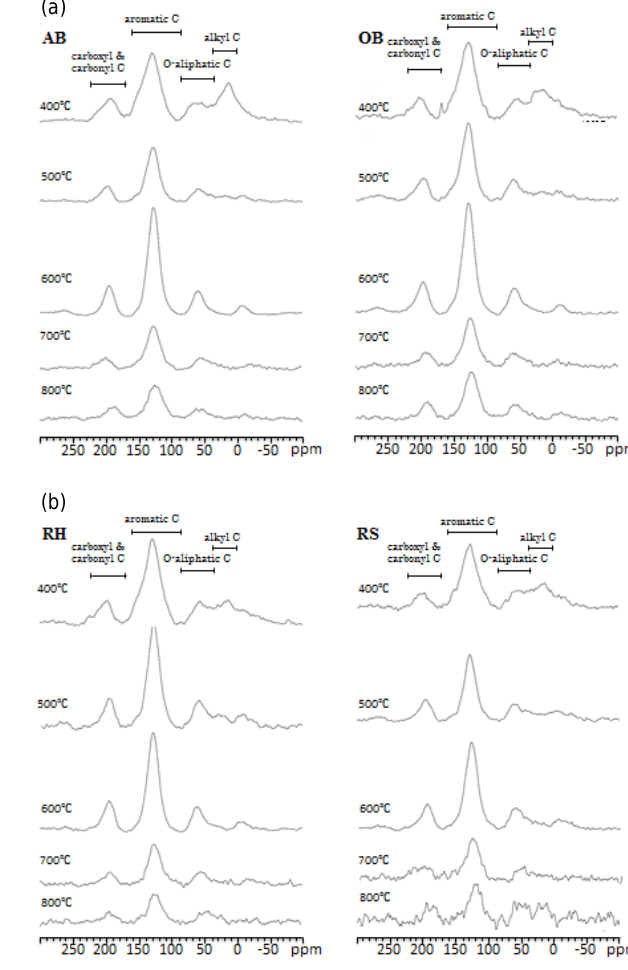
Figure 3. Fourier-transform infrared (FT-IR) spectra of the biochars obtained from (a) wood materials (apple tree branch (AB) and oak tree (OB) as well as (b) rice residues (rice husk (RH) and rice straw (RS)).